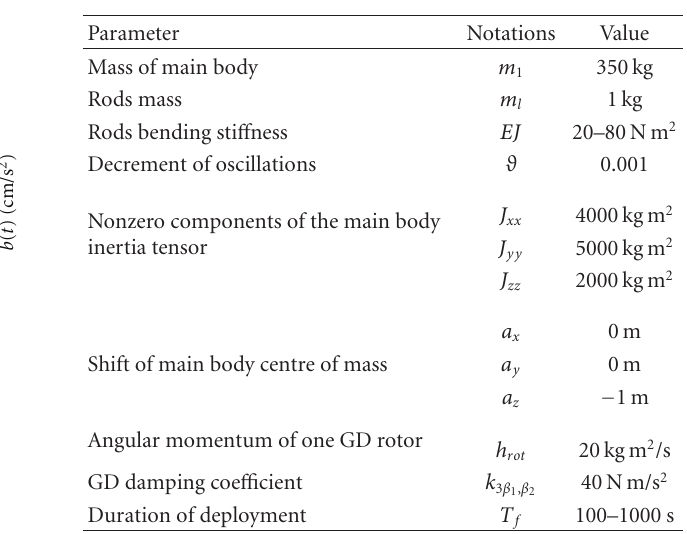
Table 1: Key system